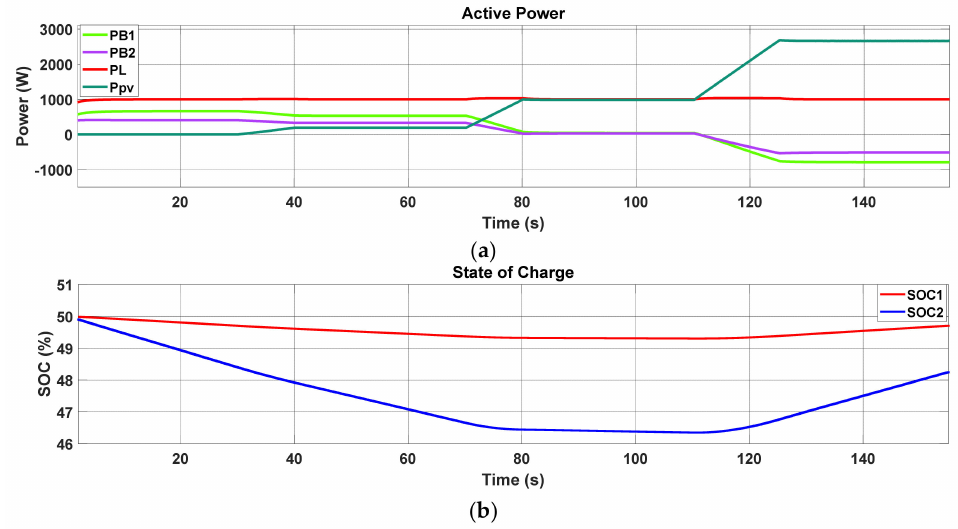
Figure 15. Distributed secondary control for voltage restoration, ( a ) system power sharing and ( b ) SOC in batteries 1 and 2 in a time of 155